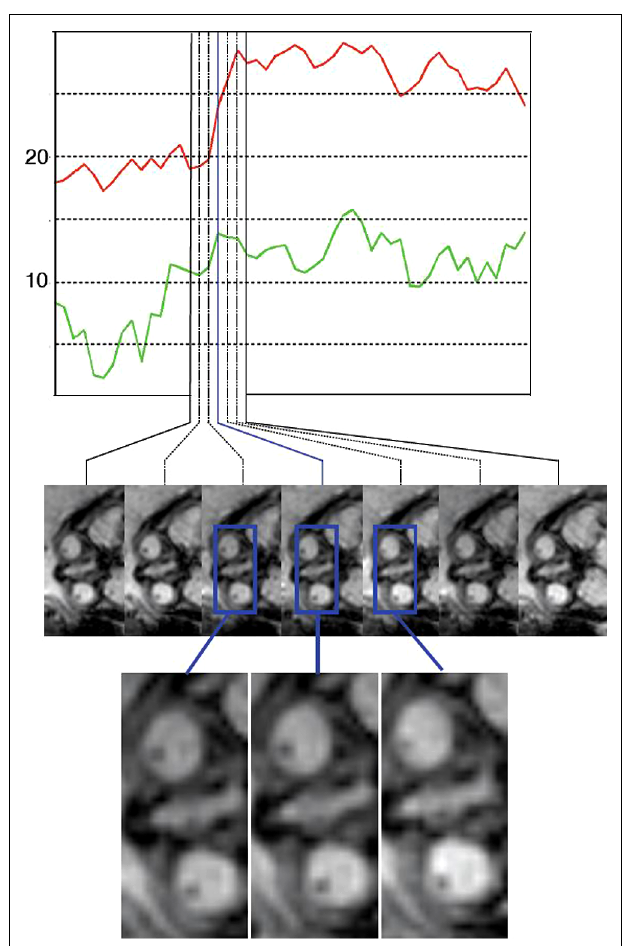
FIGURE 2 |An example of an eye movement sequence. The top plot shows the measures eye angles relative to the head axis (red for eye 1 and green for eye 2).The images below show the imaging data depicting the eyes at the corresponding time points.The eye movements are in the range of 5–7 ◦ in this sequence, and therefore qualitative analysis by a reader is